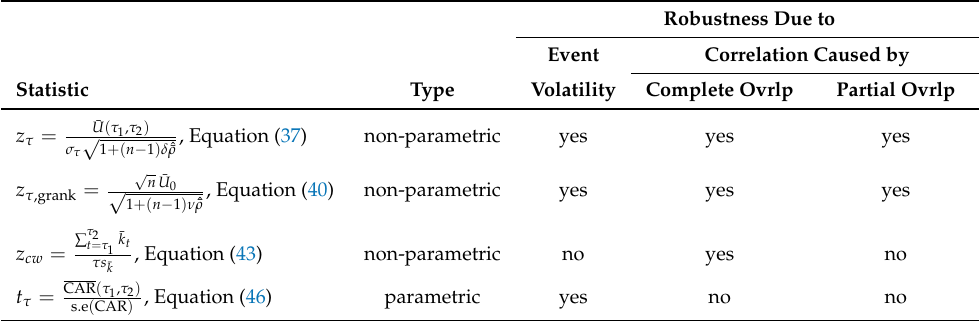
Table 1. Test statistics and their key features.